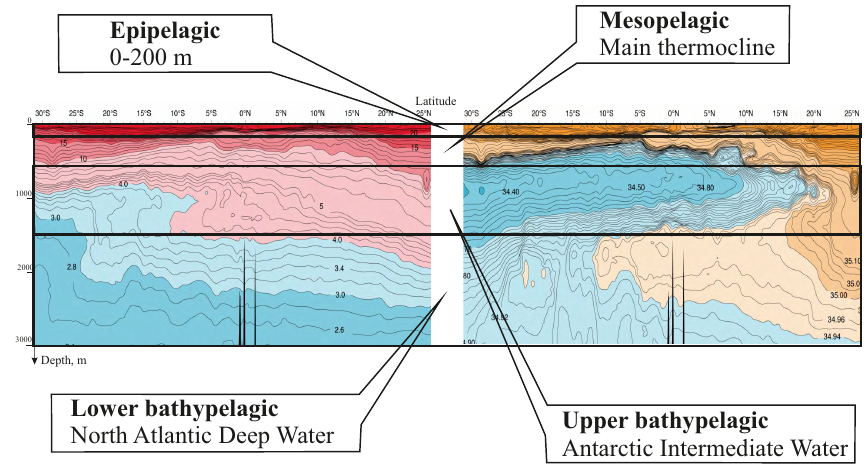
Figure 2. Temperature ( ◦ C, left) and salinity (‰, right) along transect A16 (Koltermann et al., 2011). Table 2. Average values ± SD of wet biomass the major plankton groups in the whole water column (gm − 2 ) and vertical zones (mgm − 3 ) of the Atlantic Ocean. Vertical zones Non-gelatinous Gelatinous Fishes